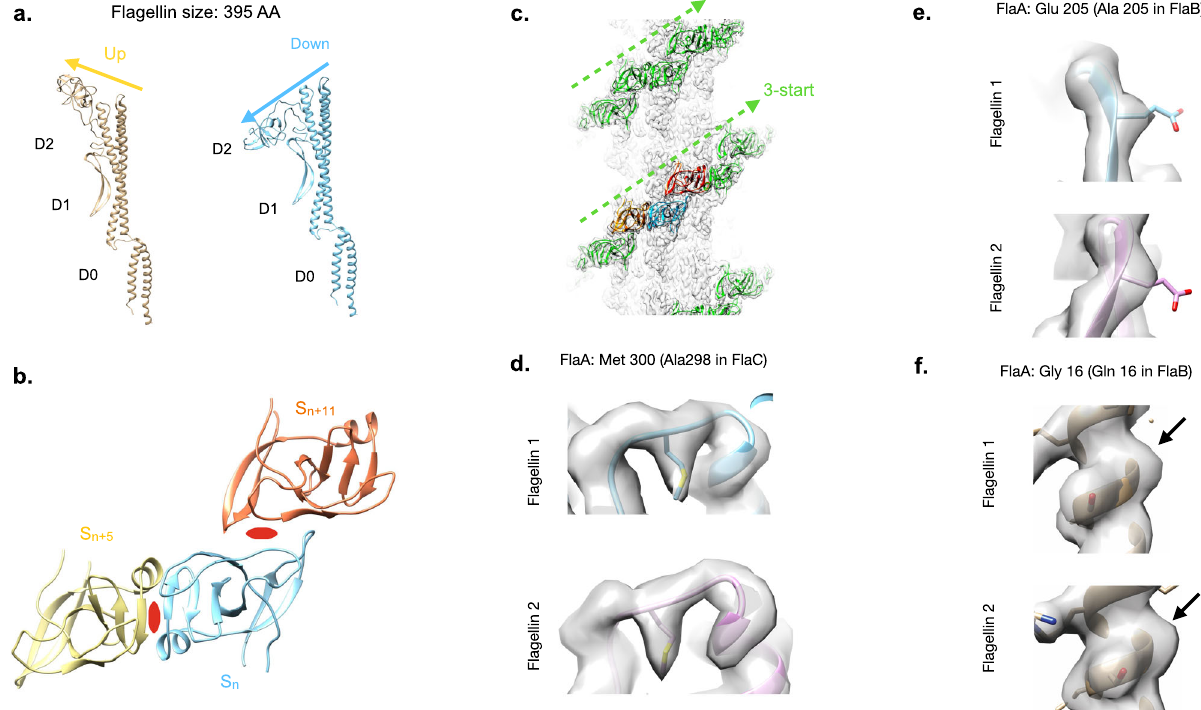
Fig. 2 Structural details of S. meliloti screw-like fl agellar fi lament. a The two fl agellin conformations of the S. meliloti fl agellar fi lament asymmetric unit. The core domains D0 and D1 are unchanged in either conformation. The outer domains however change and have either an up or down conformation. b Each S. meliloti outer domain from subunit S n interacts with the outer domains of fl agellins that are 5 (S n + 5 ) and 11 (S n + 11 ) subunits away. Two-fold axes are indicated by the red symbols. c The S n :S n + 5 and S n : S n + 11 dimers generate a right-handed 3-start helix (green) surrounding the fi lament core (light gray). d . Model and map showing methionine 300 for the FlaA model fi tting the map density well for both fl agellin conformations. e FlaA model and map density of position 205 for both fl agellins in the ASU. f FlaA model and map density of position 16 for both fl agellins in the ASU. Table 1 Helical symmetry parameters for S. meliloti , EHEC H7, Achromobacter sp. MFA1 R4, and EPEC H6.